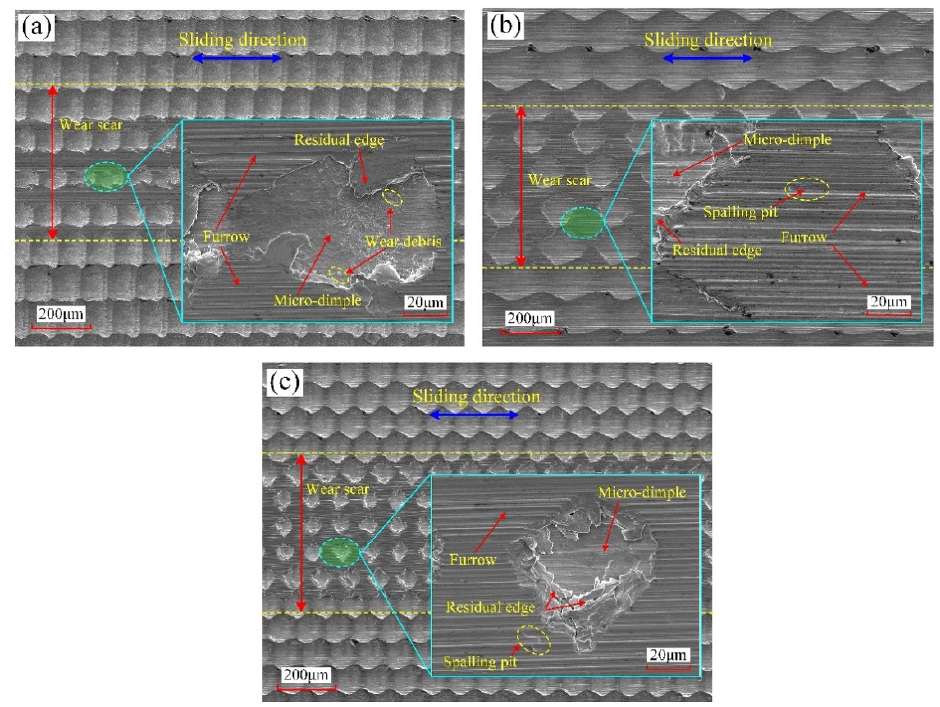
Figure 14. SEM micrographs of surface worn morphology: ( a ) surface #2; ( b ) surface #3; ( c ) surface #4.